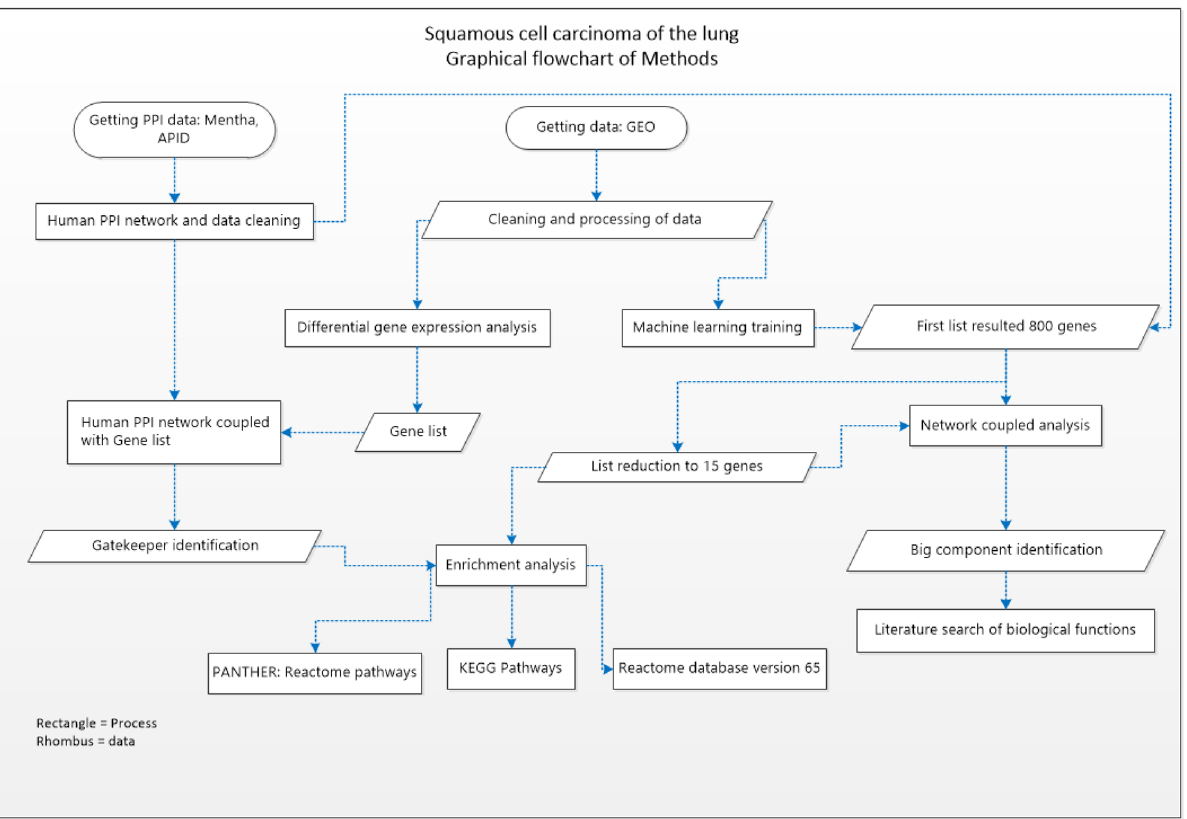
Figure 5. Workflow. A general panorama of the methodology and the databases. Figure made with Microsoft